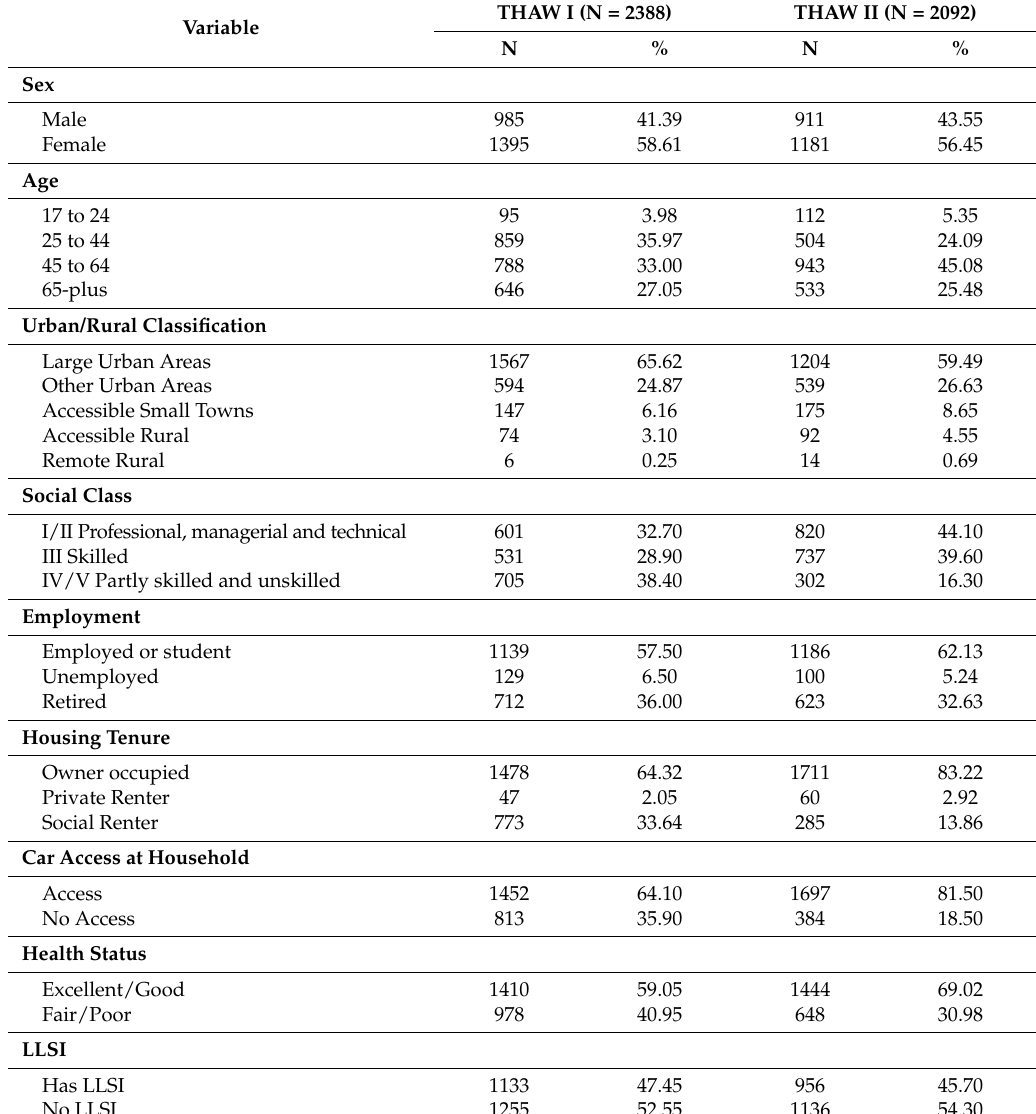
Table 1. Participant characteristics and Hospital Anxiety and Depression Scale (HADS)